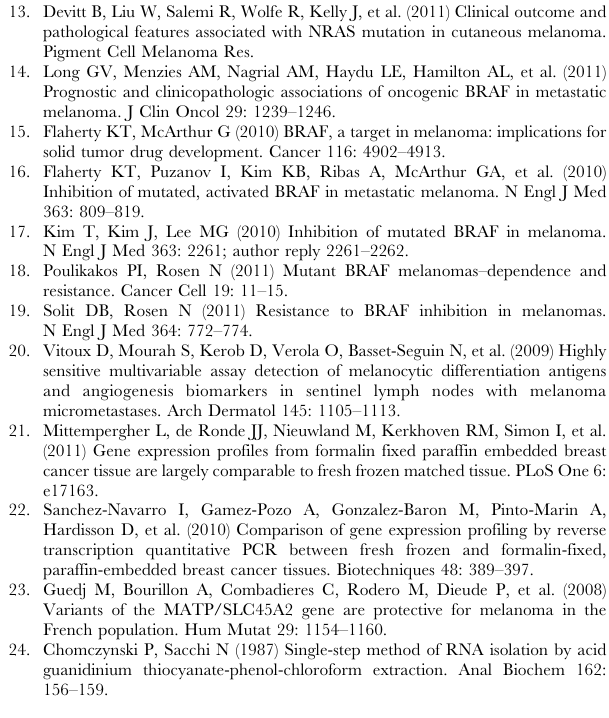
Table S1 Sample correlations and